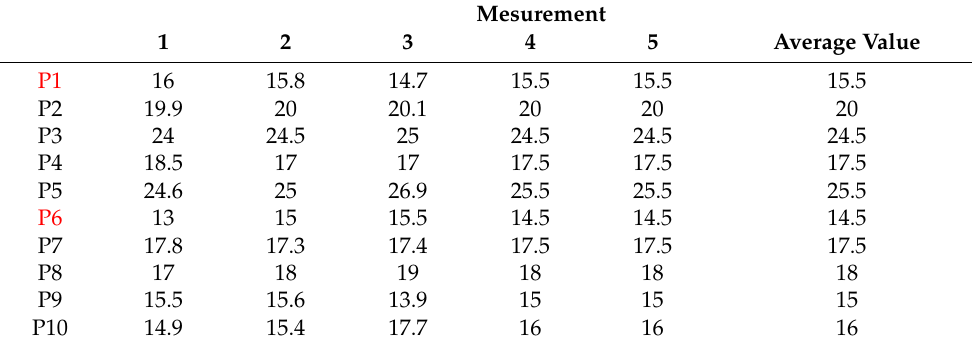
Table 3. Values of the compressive strength measurements for samples P1 to P10.